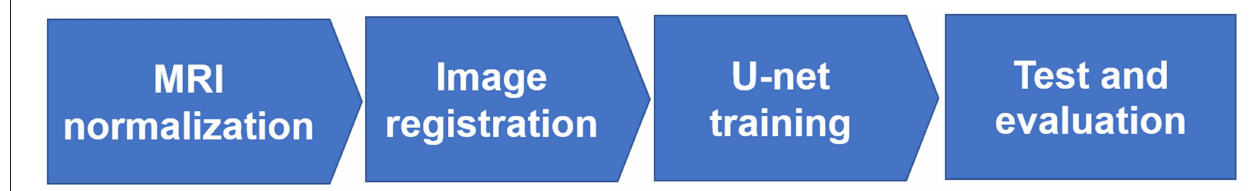
FIGURE 1 | The workflow diagram of generating synthetic CT from T2-weighted MRI using U-net.